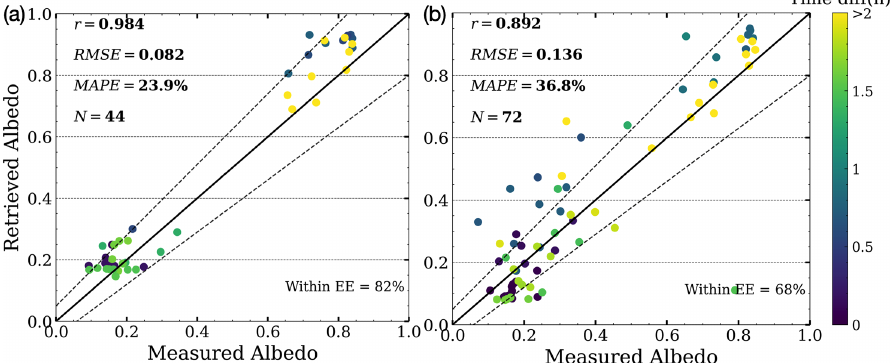
Figure 6. Correlation between shortwave albedo measurements from the AFLUX campaign and satellite overflight (SGLI a , and MODIS b ), 8 April 2019. The color indicates the time interval between campaign measurements and satellite overpass. The Pearson r coefficient ( r ), root-mean-square error (RMSE), mean absolute percentage error (MAPE), and the number of pixels ( N ) used to calculate the statistics are provided in each